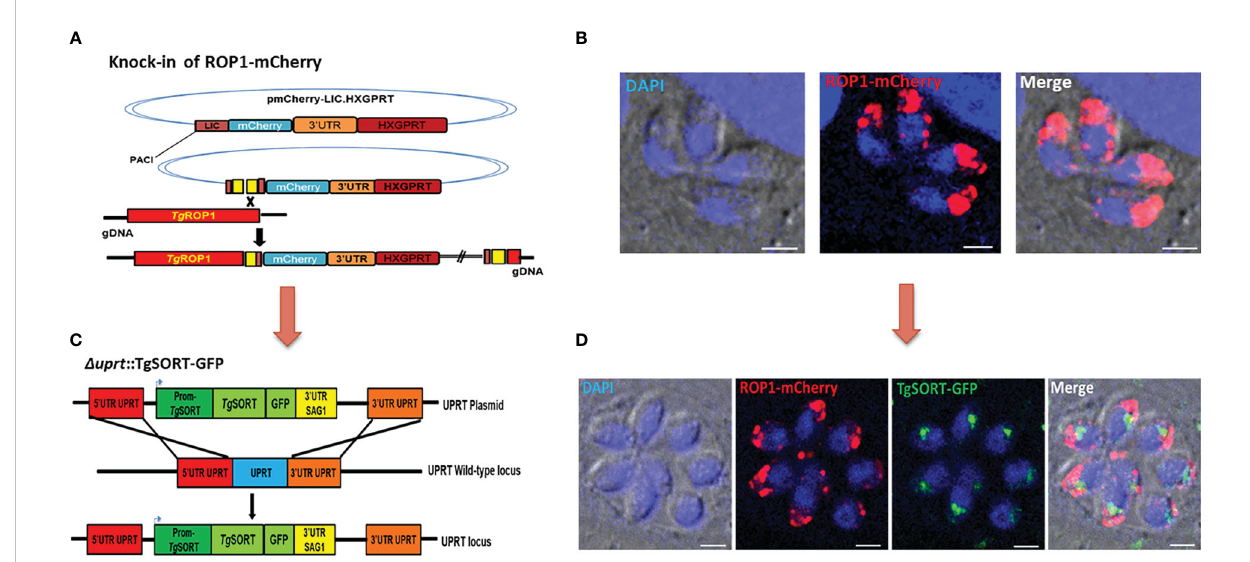
FIGURE 1 Generation of transgenic T. gondii expressing TgSORT-GFP/ROP1-mCherry. (A) corresponds to the vector that allows the knock-in of ROP1- mCherry in the parasites. One clone was selected and the red color indicates the ROP1 signal located at the apical end of four intracellular dividing tachyzoites (B) . Thus, the vector expressing the TgSORT-GFP was transfected (C) and one positive clone (green signal), which replicates into eight intracellular tachyzoites (D) for the expression of this receptor in the post-Golgi and endosome-like compartment (ELC) is shown. Bar scale = 3